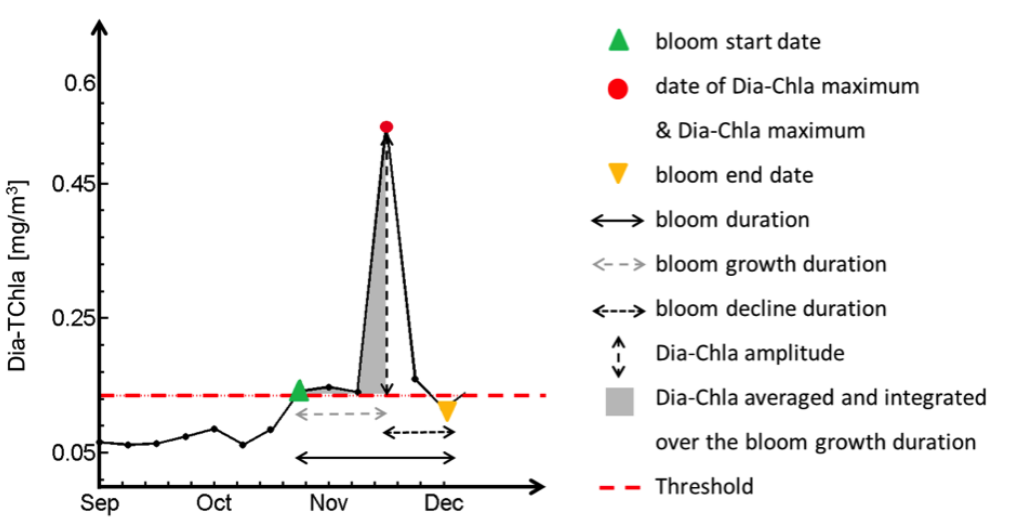
Figure 2. Schematic of the indices used to describe the diatom